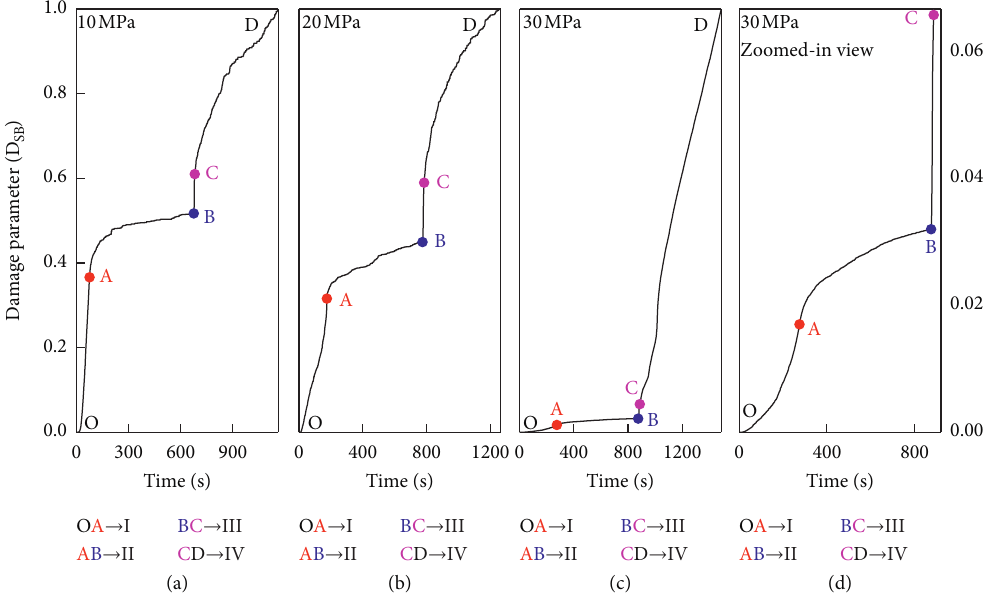
Figure 13: Damage evolution based on AE response under different initial confining stress ((a) 10, (b) 20, (c) 30MPa).